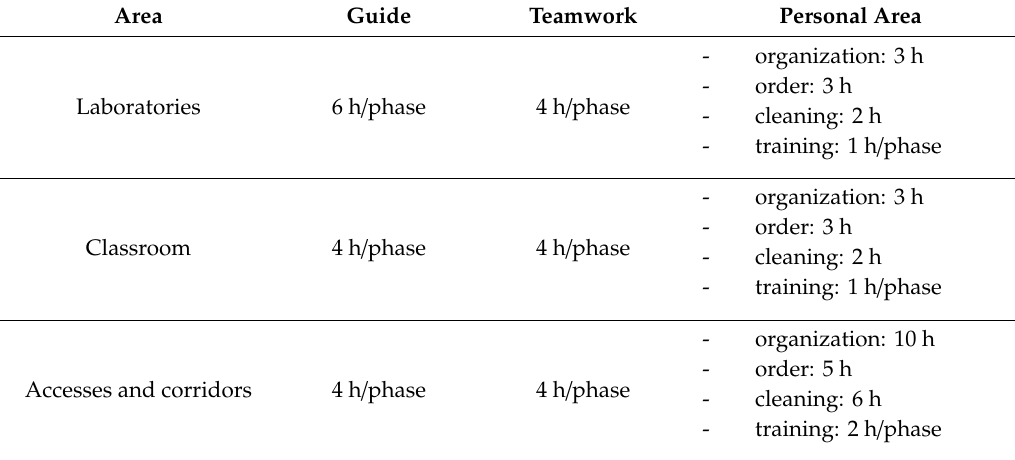
Table 6. Time expected of 6S methodology